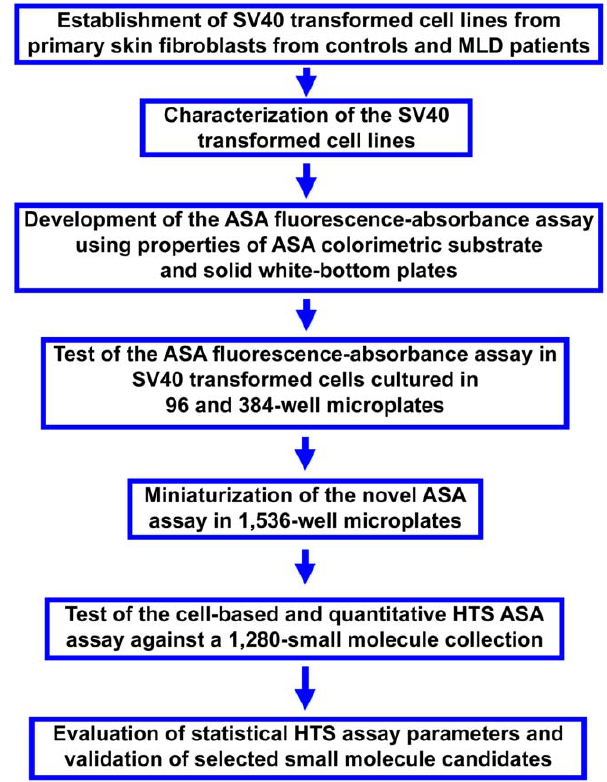
Figure 10. Algorithm summarizing the developed patient cell- based HTS assay for